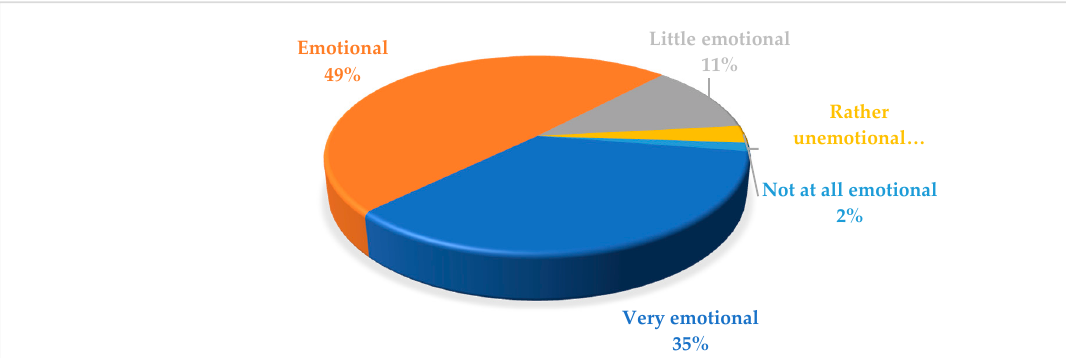
Figure 6. Burden charge of the messages.